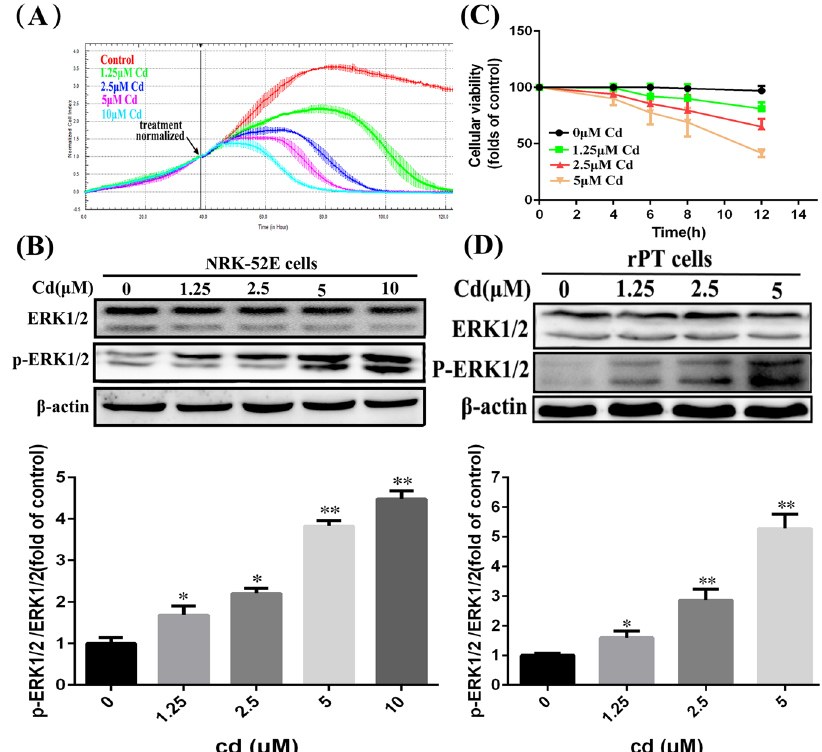
Figure 1. Effects of cadmium on cell proliferation and survival. ( A ) Cd inhibited the proliferation of NRK-52E cells. Normalized cell index were determined by RTCA after treated with 1.25, 2.5, 5 or 10 μ M Cd and Error bars indicate SD (n = 3). ( B ) Western blot analysis of the expression of ERK1/2 and p-ERK1/2 protein in NRK- 52E cells after treated with 1.25, 2.5, 5 or 10 μ M Cd for 12 h, and the rate of p-ERK1/2/ERK1/2 was significantly increased in 5, 10 μ M Cd group that compared with the control group. ( C ) Cell counting kit-8 method to detect the effect of Cd (1.25, 2.5, 5 μ M) on the proliferation of primary rPT cells, and compared with the control group, the survival rate of primary rPT cells decreased gradually. ( D ) Western blot analysis of the expression of ERK1/2 and p-ERK1/2 protein in primary rPT cells after treated with 1.25, 2.5 or 5 μ M Cd for 12 h, and the rate of p-ERK1/2/ERK1/2 was significantly increased in 2.5, 5 μ M Cd group that compared with the control group. n = 3). * P < 0.05; ** P < 0.01 vs. the control group by one-way